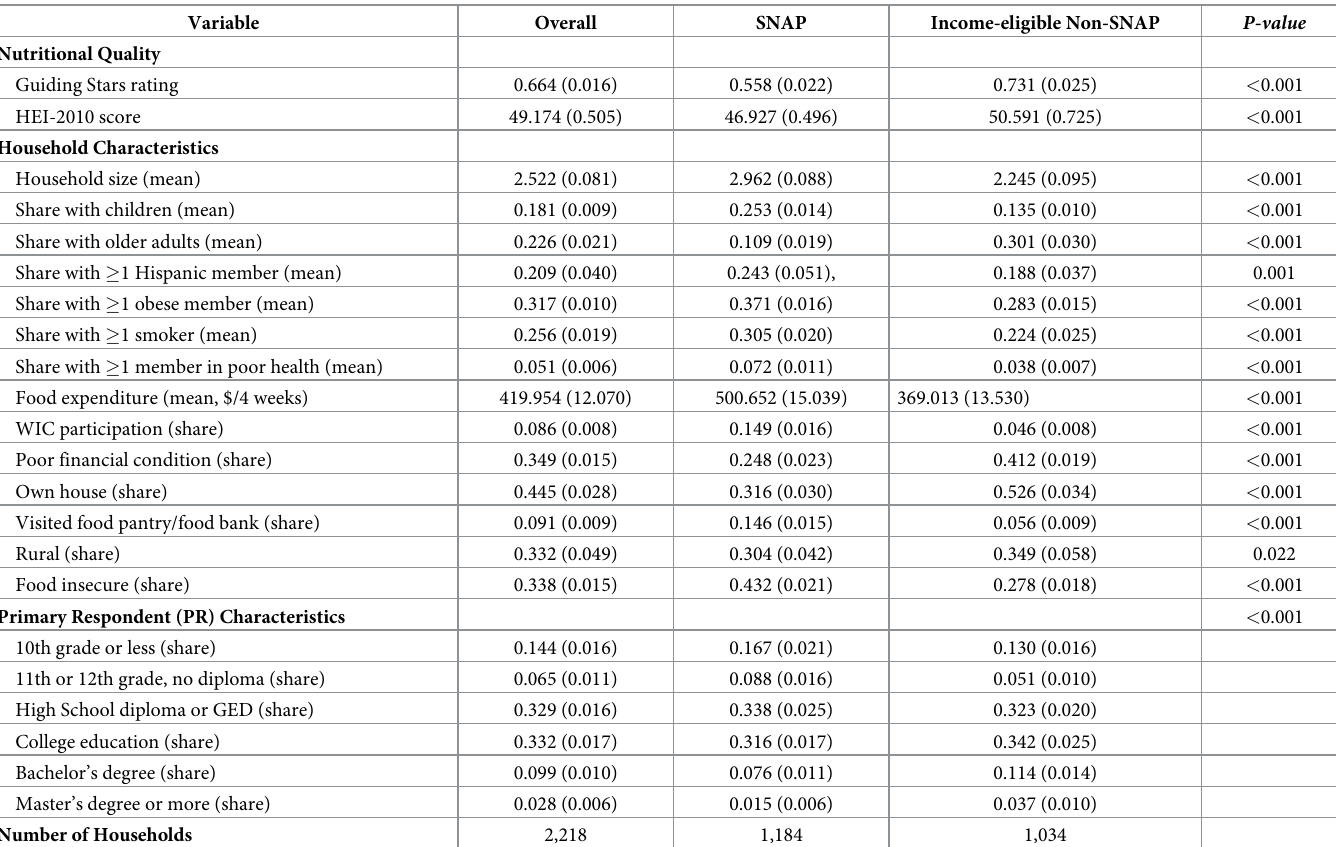
Table 1. Summary statistics of low-income households’